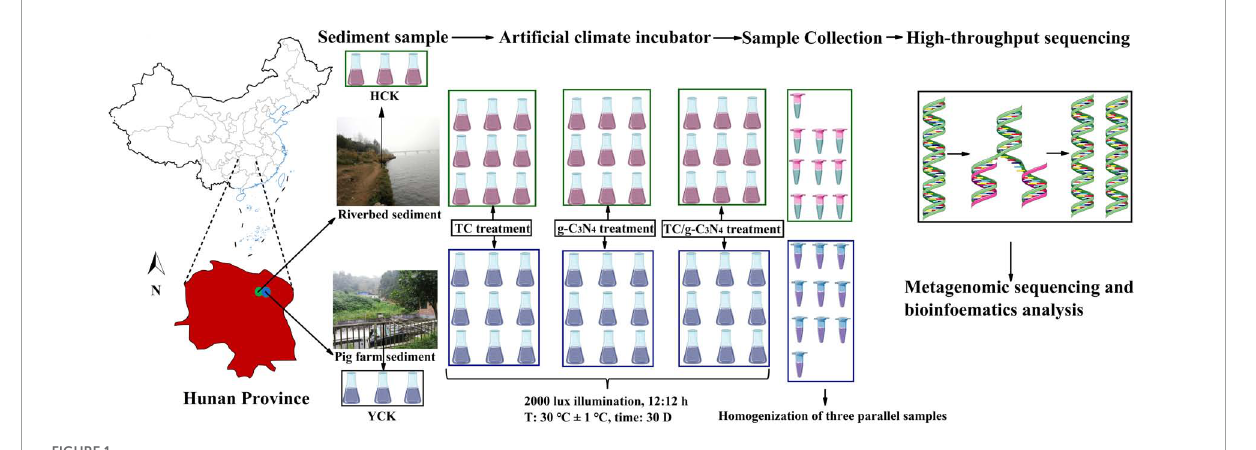
FIGURE1 Location of the study site, with sediment sampling and experimental design.